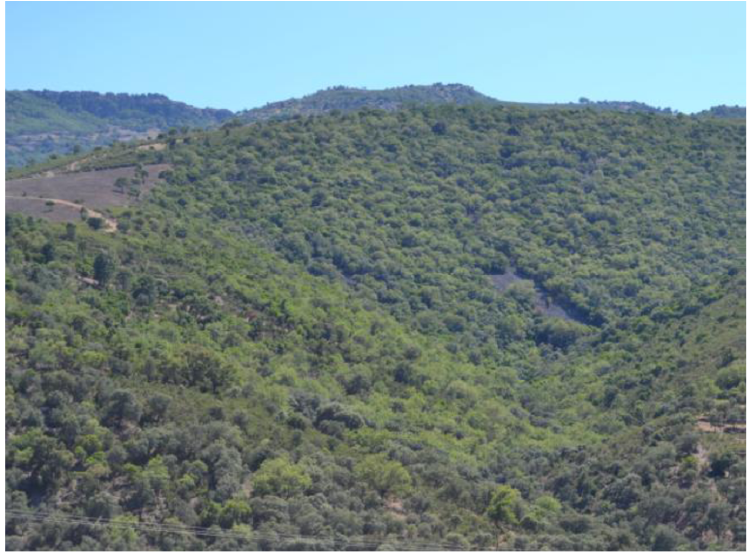
Figure 11. Pistacio terebinthi – Quercetum broteroi .